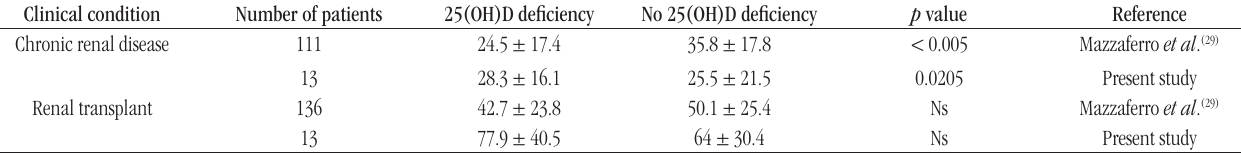
taBLE 3 − Concentration of 1,25(OH) D in patients with chronic kidney disease, and renal transplant patients, with and without 25(OH)D deficiency (pg/ml) 2 Clinical condition Number of patients 25(OH)D deficiency p value Reference Chronic renal disease Renal transplant Ns: not